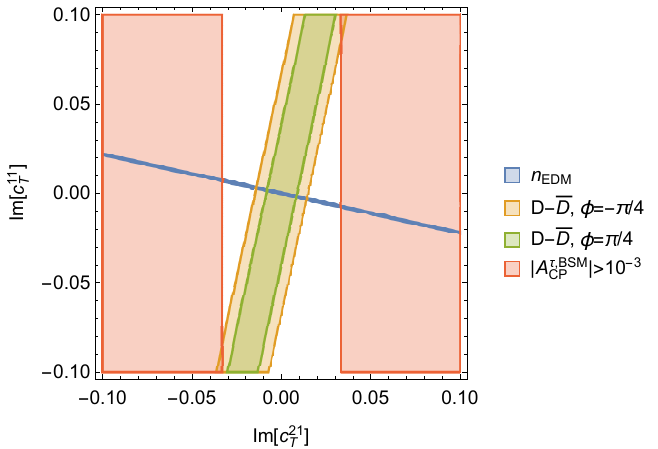
Figure 3: Allowed regions in the Im c 21 ¯ D mixing (for φ = ± π/ 4 and Λ = 1TeV), compared to the favored region from the τ → K πν τ CP S